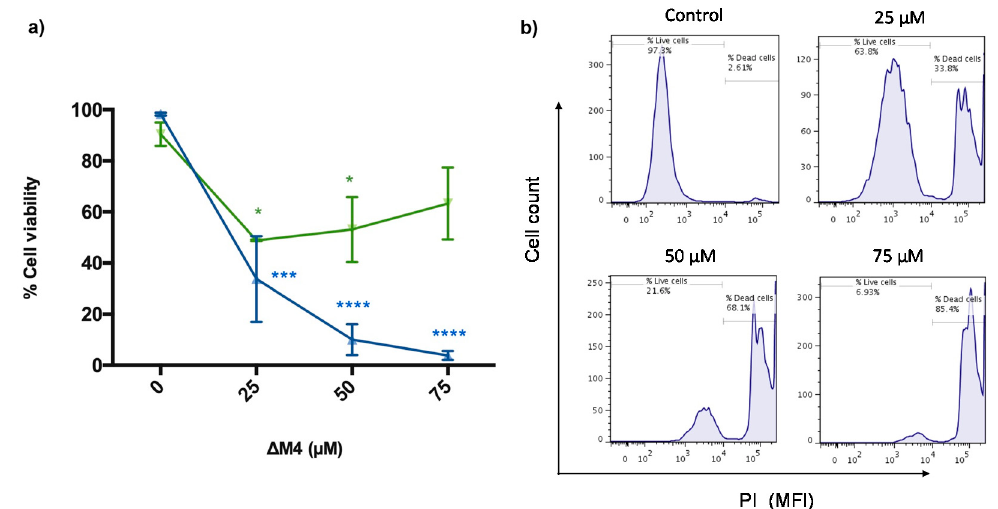
Figure 2. Selective cytotoxic effect of Δ M4 in A375 cells. ( a ) Tumoral ( ▲ ) and non-tumoral cells ( ▼ ) were treated with different concentrations of peptide for 24 h, before being dyed with propidium iodide (PI) and analyzed by flow cytometry. The percentage of viable cells in tumoral A375 and non-tumoral HaCaT cell lines was determined by PI staining, where live cells exclude the dye and dead cells are positive for it. Values are expressed as the mean ± standard error of the mean (SEM) of three independent experiments. Two-way ANOVA presented the difference with respect to non-treated cells, where * p ≤ 0.05, *** p ≤ 0.001, and **** p ≤ 0.0001. ( b ) Membrane-permeabilization activity of the Δ M4 peptide in tumoral A375 cells assayed for PI uptake by flow cytometry. The histograms show a representative example of the mean fluorescence intensity (MFI) of the dye in each treatment.